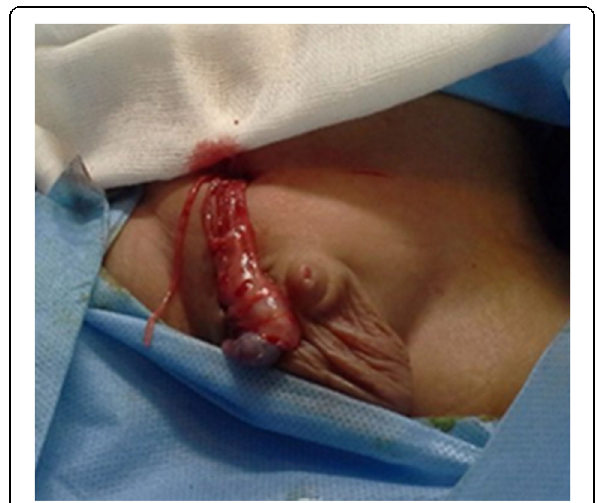
Fig. 14 Congenital separated right vas